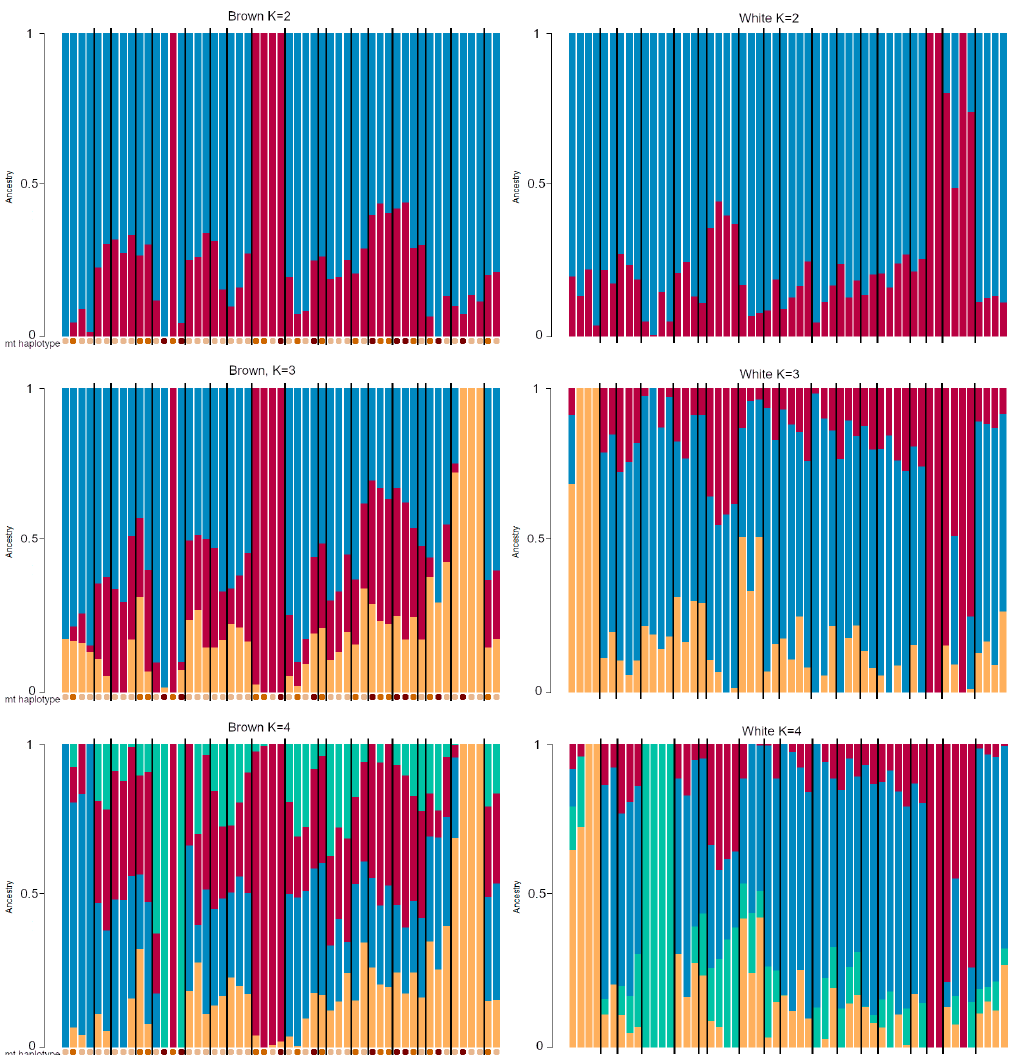
Figure 3. ADMIXTURE plots of the brown and white strain analyzed and filtered separately. Lines separate groups of individuals sharing the same father. Dots under the plots of brown individuals mark the different mt haplotypes.